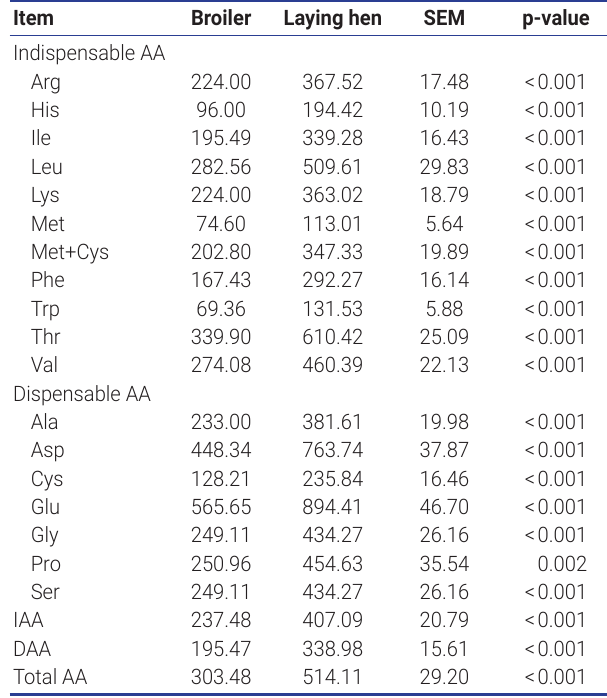
Table 6. Basal ileal endogenous AA flow of 21-day-old broilers and 35 week-old laying hens fed an N-free diet (mg/kg DMI)